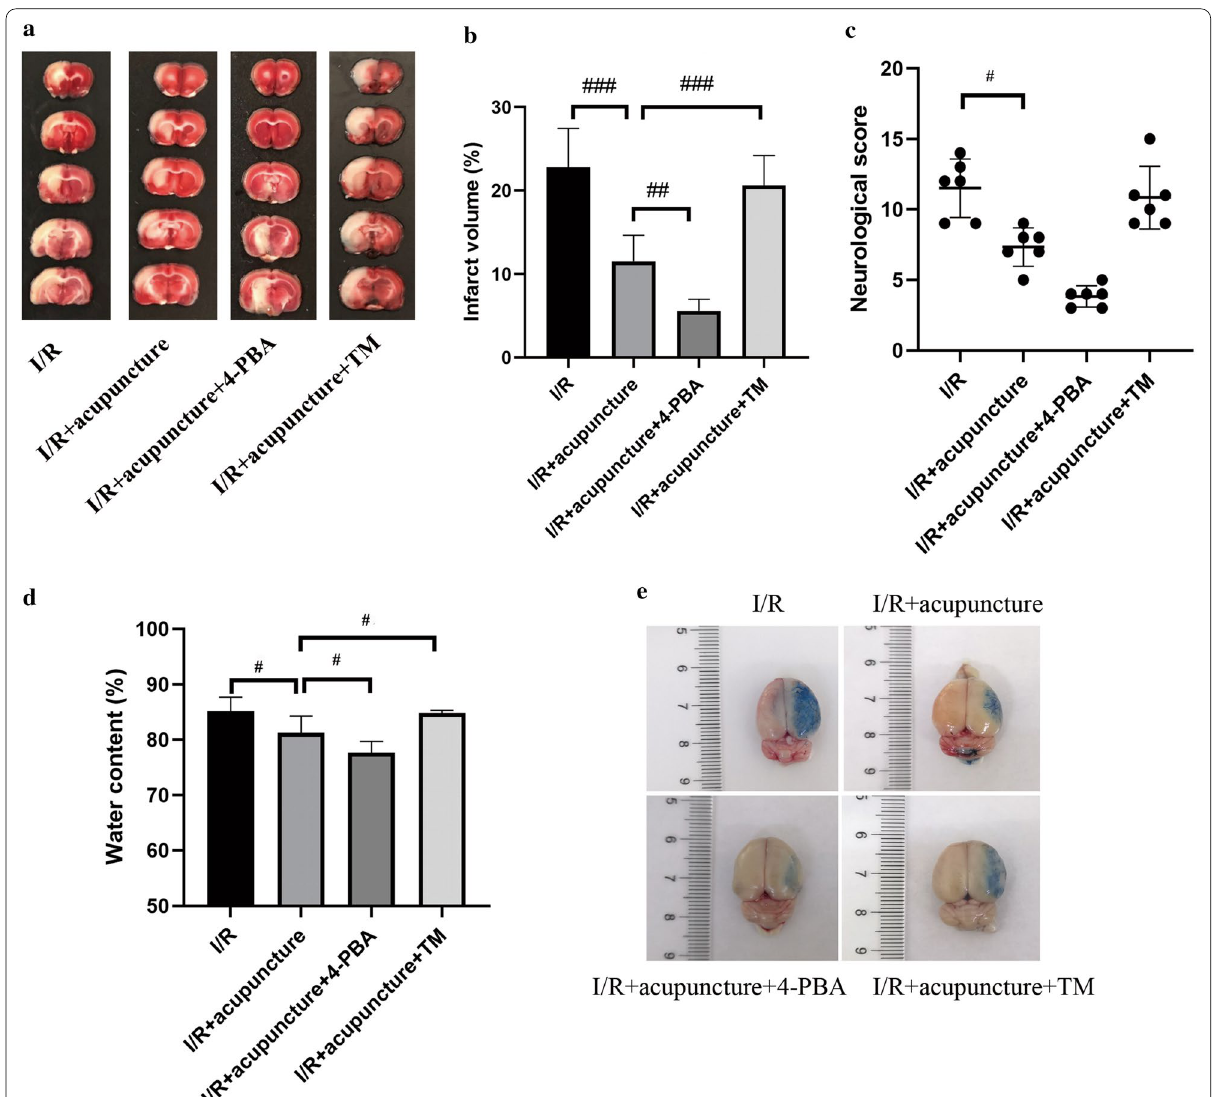
Fig. 7 Acupuncture relieved cerebral ischemia–reperfusion (I/R) injury via suppressing endoplasmic reticulum (ER) stress. a , b The infarct volume of rats at 72 h after reperfusion in the four groups (I/R, I/R acupuncture, I/R acupuncture 4-PBA, I/R acupuncture tunicamycin (TM)) was + + + + + detected by TTC staining. Brain infarct volume presented as a percentage of the infarct hemisphere. c The neurological deficits were determined by neurological score at 72 h after reperfusion. Neurological scores are presented as median (interquartile range). d Water content was determined. Results represent at least three independent experiments. e Blood brain barrier leakage was detected by Evans blue staining. Each experimental result was presented as mean standard deviation (n 6). # P < 0.05, ### P < 0.001 versus the indicated ± =